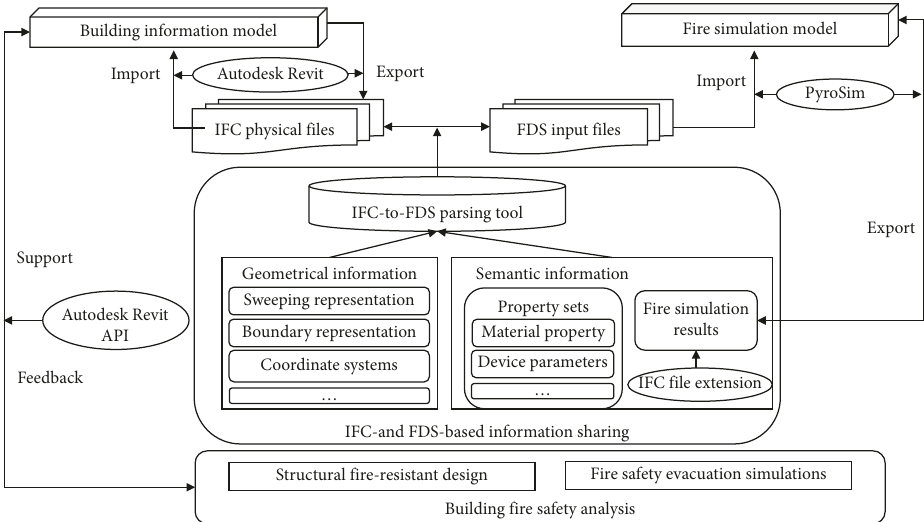
Figure 1: The framework of IFC and FDS-based information sharing for building fire safety analysis.